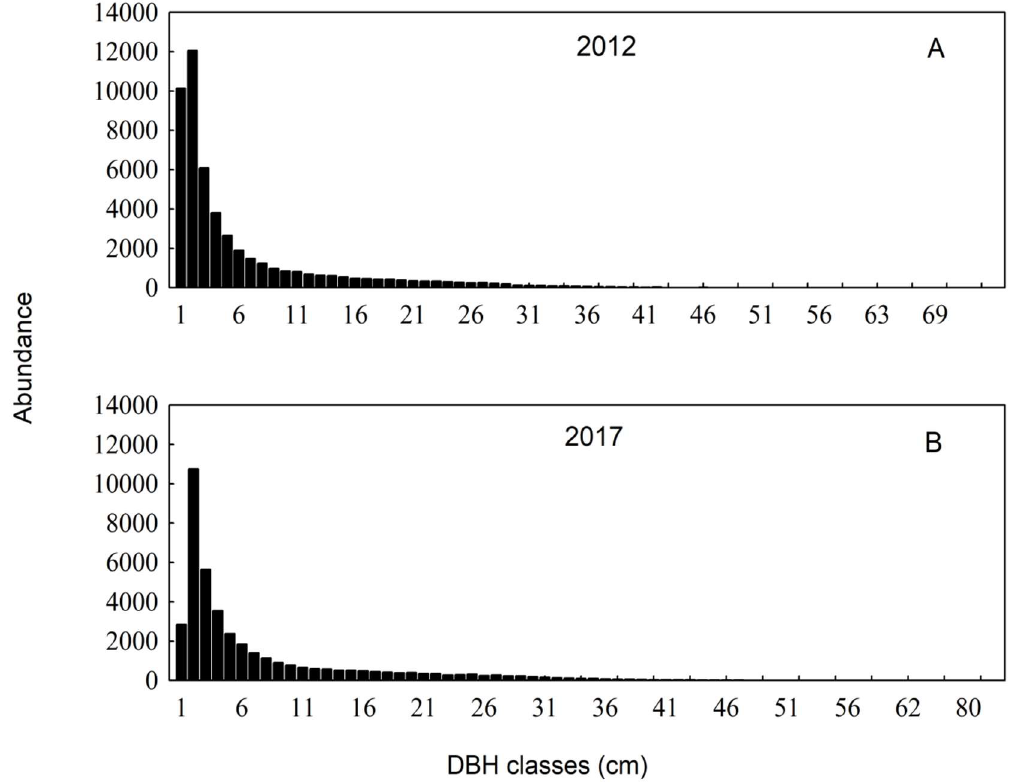
Figure 2. The dynamic changes of size-structure during forest succession from 2012 ( A ) to (2017) ( B) .